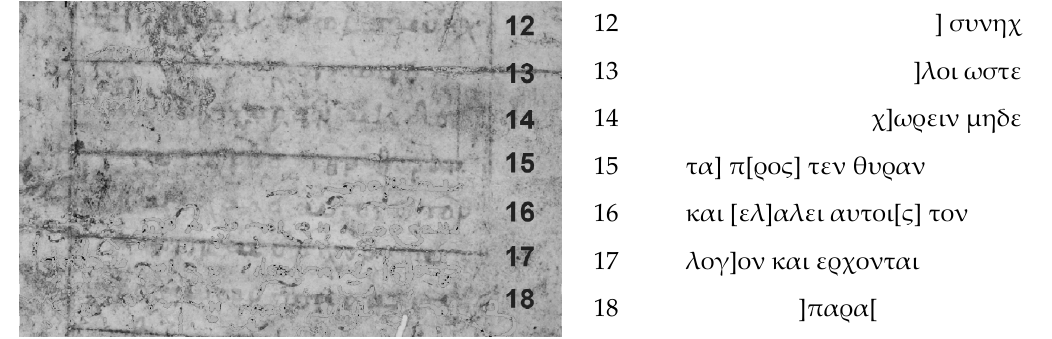
Figure 3. Detail of O.9.27, flyleaf, containing Mark 2:2. Used with permission from the Master and Fellows of Trinity College